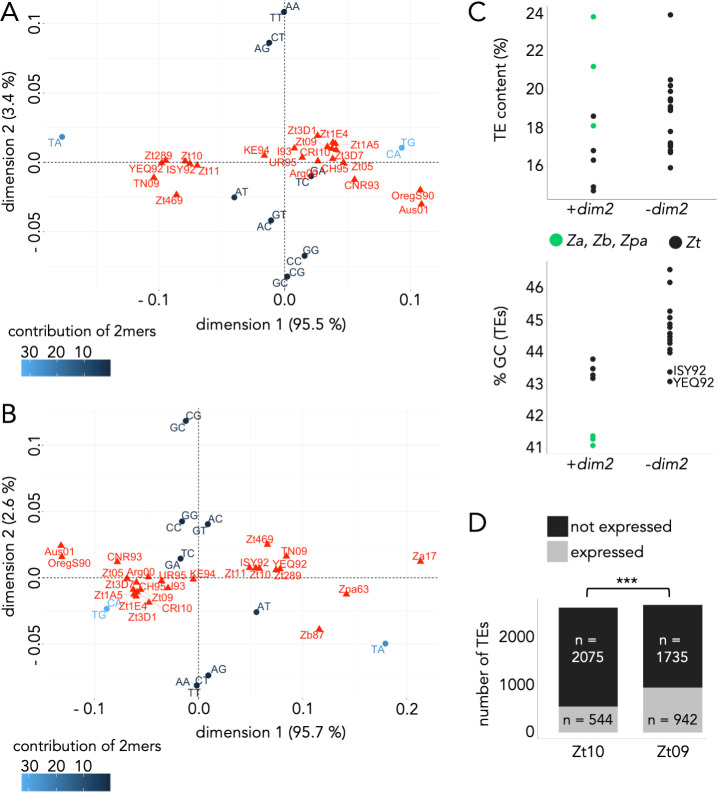
Impact of Dim2 on nucleotide composition and TE activity.(A) and (B) Correspondence analyses showing differences in dinucleotide (2mer) frequencies in TEs of different Z. tritici isolates (A) and other members of the Zymoseptoria species complex (B). TA and CA/TG dinucleotide frequencies have the highest impact on the observed differences between isolates and species, indicated by their relative positions on the dimension 1 versus dimension 2 plot. Isolates (even from different species) containing a functional dim2 (Zt10, Zt289, Zt11, Zt469, TN09, Zb87, Za17, Zpa63) and recently mutated dim2 (ISY92 and YEQ92) have higher TA content and cluster together, while isolates without functional dim2 have higher CA/TG frequencies in TE sequences. (C) Comparison of TE and GC content between different Z. tritici isolates and Zymoseptoria species with and without functional dim2. D) Number of expressed TEs during the time course of wheat infection is significantly higher in Z. tritici isolate Zt09 (non-functional dim2) compared to Zt10 (functional dim2) (Fisher’s Exact Test for Count Data, p-value < 2.2 x 10−16).